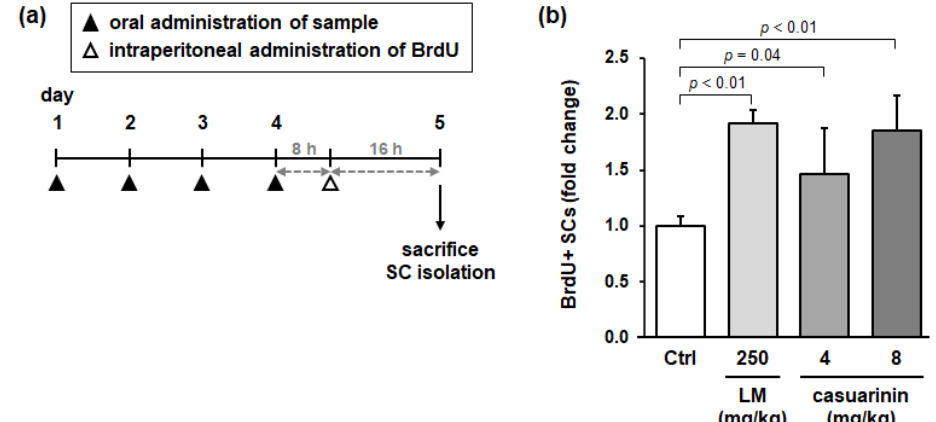
Figure 6. Both LM and casuarinin promote BrdU incorporation into SCs in vivo. ( a ) Experimental design of the BrdU-incorporation assay in rats. Each group of animals was orally administered water (Ctrl), LM, or casuarinin daily for 4 d. Eight hours after the last administration of each sample, all animals were intraperitoneally administered BrdU (50 mg/kg), and then 16 h later, animals were sacrificed and SCs were isolated. ( b ) Effects of LM and casuarinin administration on BrdU incorporation into SCs. The daily dose of each sample is shown in the figure. BrdU incorporation into SCs is expressed as BrdU + SCs per total SCs and is shown as a fold change compared to the Ctrl. Data represent the mean ± SD of each group (three independent cultures per rat). Significant differences ( p < 0.05) relative to the Ctrl are indicated in the figure, and non-significant differences ( p > 0.05) are not shown in the figure.